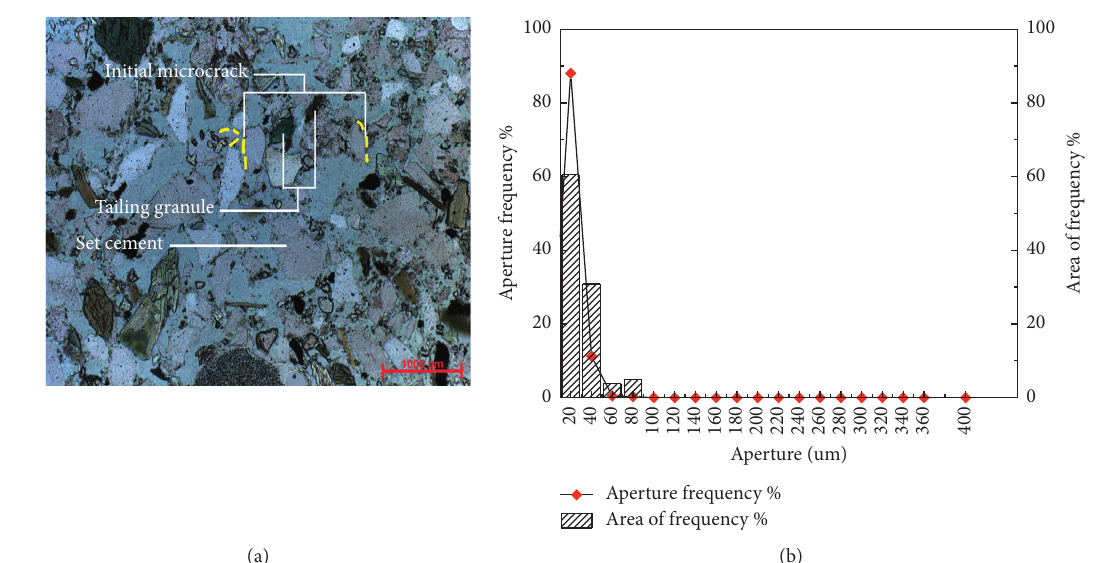
Figure 5: Original specimen of the cast thin section. (a) Slice image. (b) Pore statistical histogram.